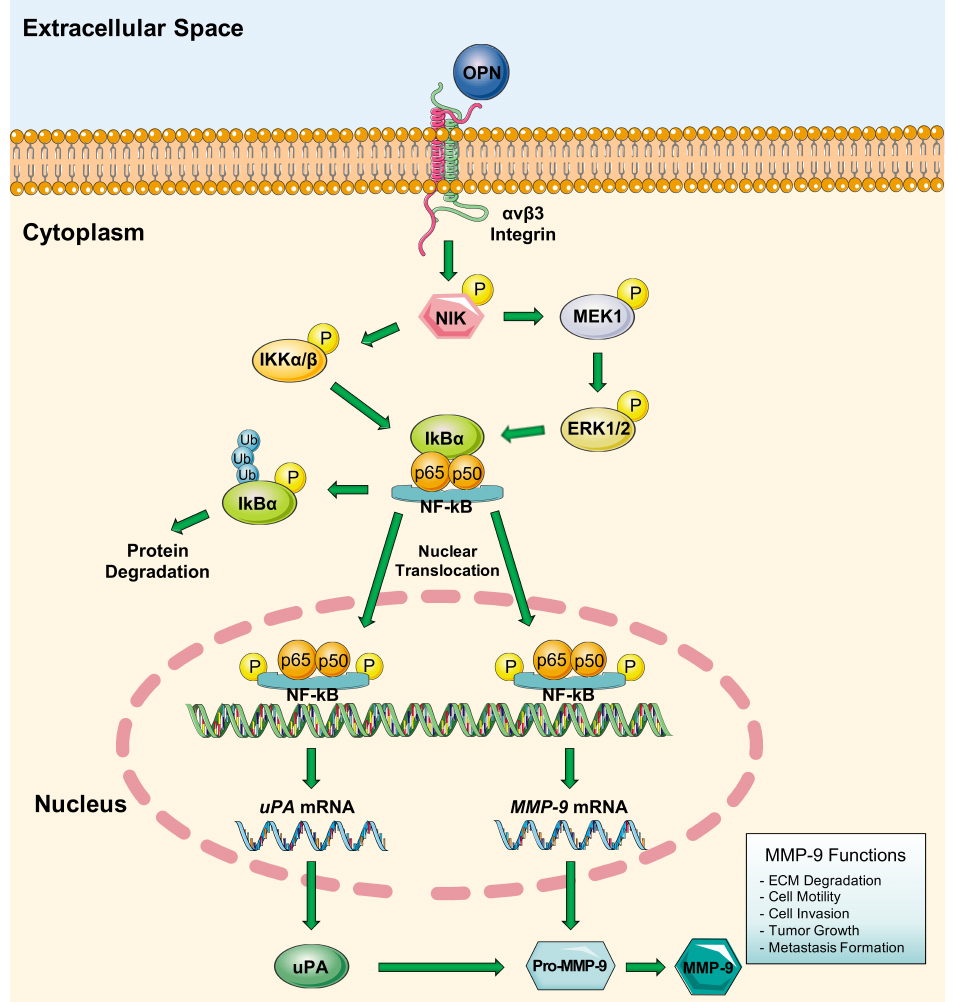
Figure 3. Schematic representation of MMP-9 activation mediated by OPN. The binding between OPN and α v β 3 integrin induce the phosphorylation and activation of NIK protein. NIK is able to induce the activation of the protein complex NF- κ B / p65 / p50 through two di ff erent mechanisms: (1) NIK activates IKK α / β then IKK α / β phosphorylated is able to disrupt the binding between NF- κ B / p65 / p50 complex and IkB α , thus, activating NF- κ B and inducing IkB α ubiquitination and degradation; (2) NIK is able to activate MEK1 / ERK1 / 2 cascade through phosphorylation, phosphorylated ERK1 / 2 thus activate NF- κ B by removing IkB α . Finally, NF- κ B / p65 / p50 activated complex moves within the nucleus inducing the transcription and production of Pro-MMP-9 and uPA. This latter protein is able to bind Pro-MMP-9 leading to the production of MMP-9 active